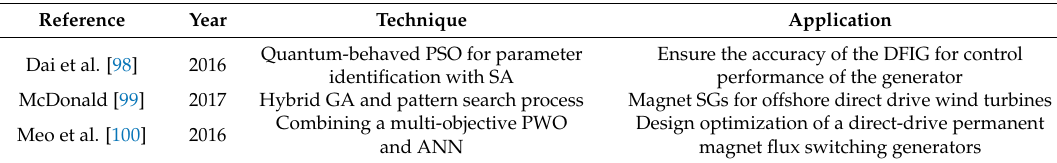
Table 11. Application of hybrid methods in the field of electrical machines and power systems.